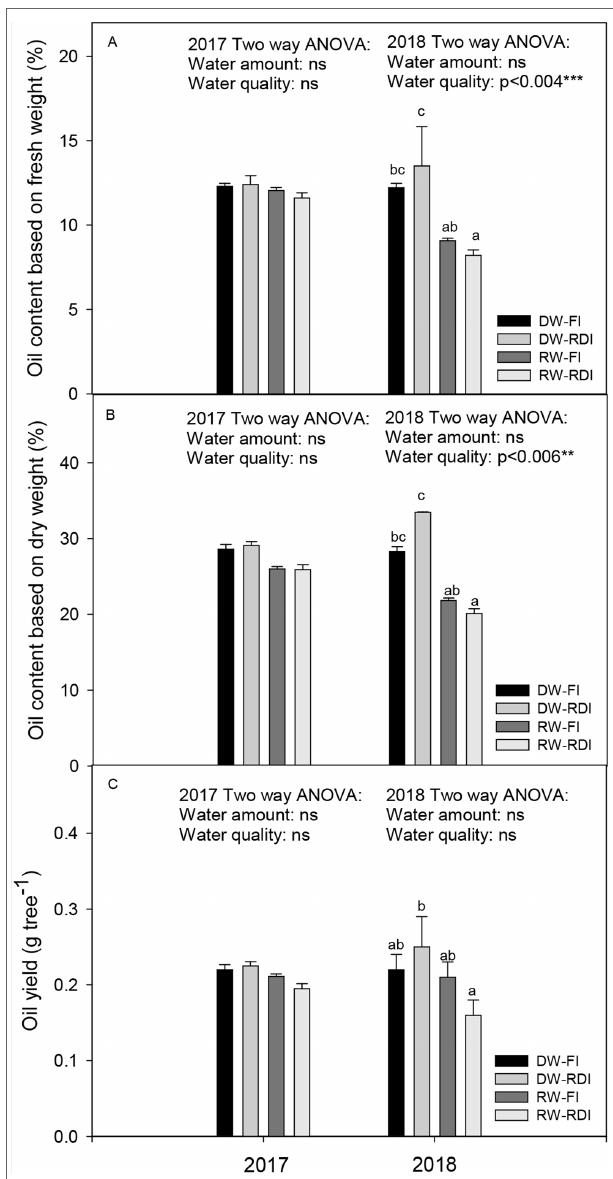
FIGURE 4 | Oil content based on (A) fresh fruit weight (%), (B) oil content based on dry fruit weight (%) and (C) oil yield (g tree−1) for each treatment: DW-FI (DESERT water-full irrigation), DW-RDI (DESERT water-regulated deficit irrigation), RW-FI (reclaimed water-full irrigation) and RW-RDI (reclaimed water-regulated deficit irrigation) in 2017 and